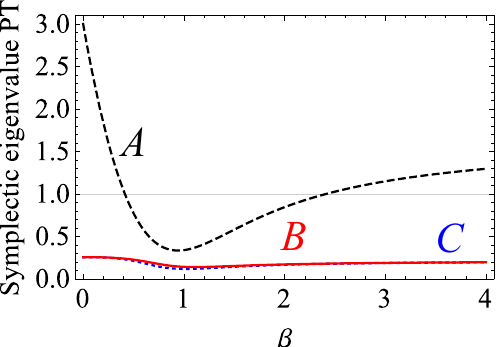
Figure 5. The dependence of smallest symplectic eigenvalues E ˆ E ˆ ( C ) on feedforward gain β under the conditions of G 1 = G 2 = G 3 = 2 and η = A 2 − ˆ C 1 ˆ A 3